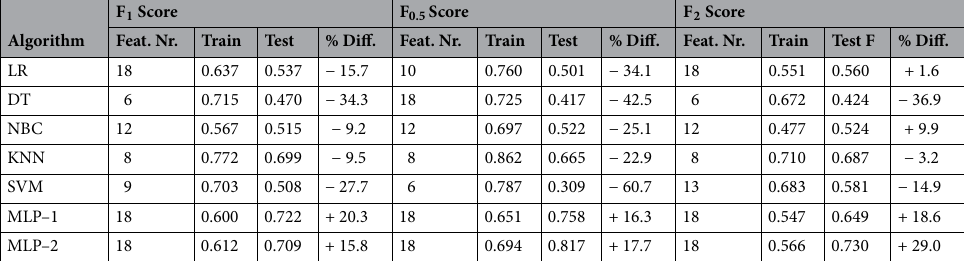
Table 2. External test results of the optimized models on the external unseen test dataset. For each model it is indicated the number of features, together with the average training and test F 1 , F 0.5 and F 2 scores, and the difference between